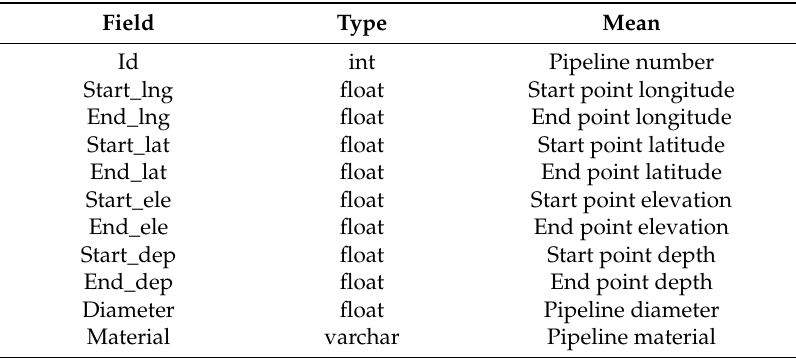
Table 1. Structure of pipeline spatial